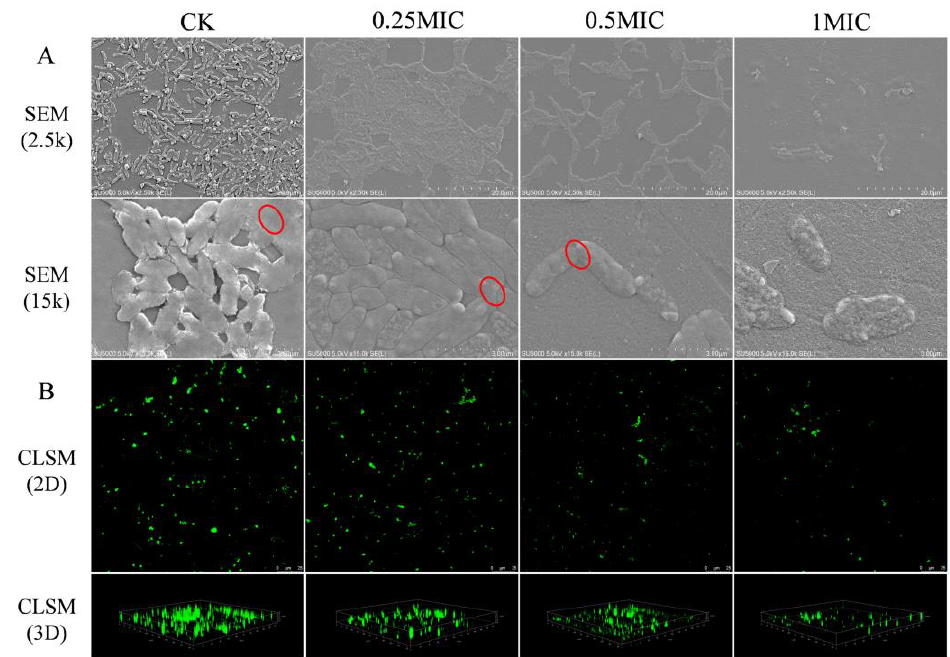
Figure 5. ( A ) SEM photography, ( B ) CLSM photography. A indicates the biofilms of S. putrefaciens at different SEM magnifications (2.5k, 15k), and the connections between biofilms are marked with red circles. ( B ) shows the CLSM images of S. putrefaciens biofilms in 2D and 3D.